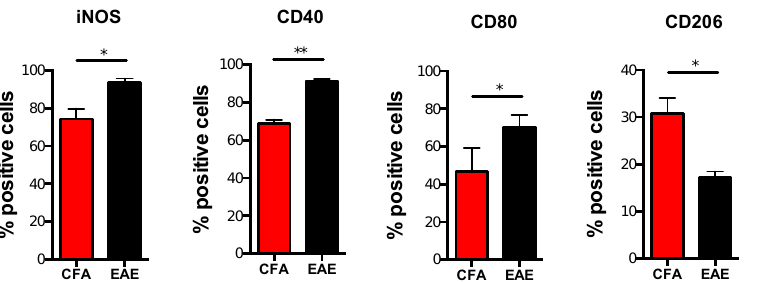
Figure 3. Immunophenotype of M1 macrophages obtained from CFA and EAE mice. Expression of markers by flow cytometry upon staining cells at cell surface (CD40, CD80 and CD206) or intracellularly (iNOS) in M1 and M2 macrophages obtained from CFA and EAE mice. Data are reported as percentage of positive cells and are representative of eight independent experiments ± SEM * p < 0.05, ** p < 0.01.